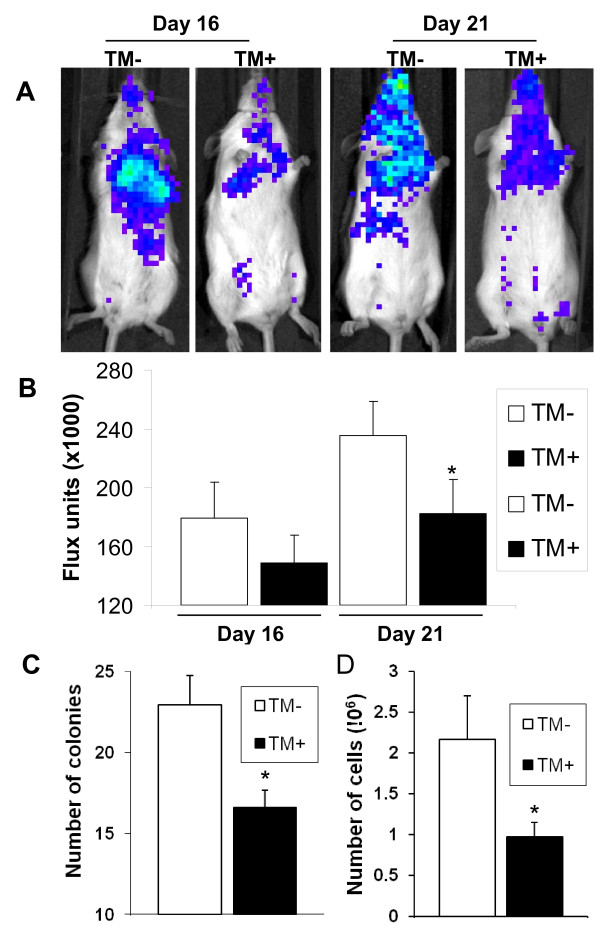
TM treatment significantly inhibits HNSCC tumor metastasis. OSCC-3-Luc cells were injected in the SCID mice via tail vein. Tumor metastasis to lungs was monitored by in vivo bioluminescence imaging. A; representative photomicrograph of animals treated with (TM+) or without TM (TM-) at days 16 and 21. B; Quantitative data of bioluminescence imagining as expressed as flux units. C; Tumor cells from lungs were harvested and tumor cell colonies were selected by G418 treatment (200 μg/ml) for one week and counted. D; Tumor cell colonies were then trypsinized and total number of cells were counted. *, represents a significant difference (p < 0.05) as compared to the control group.